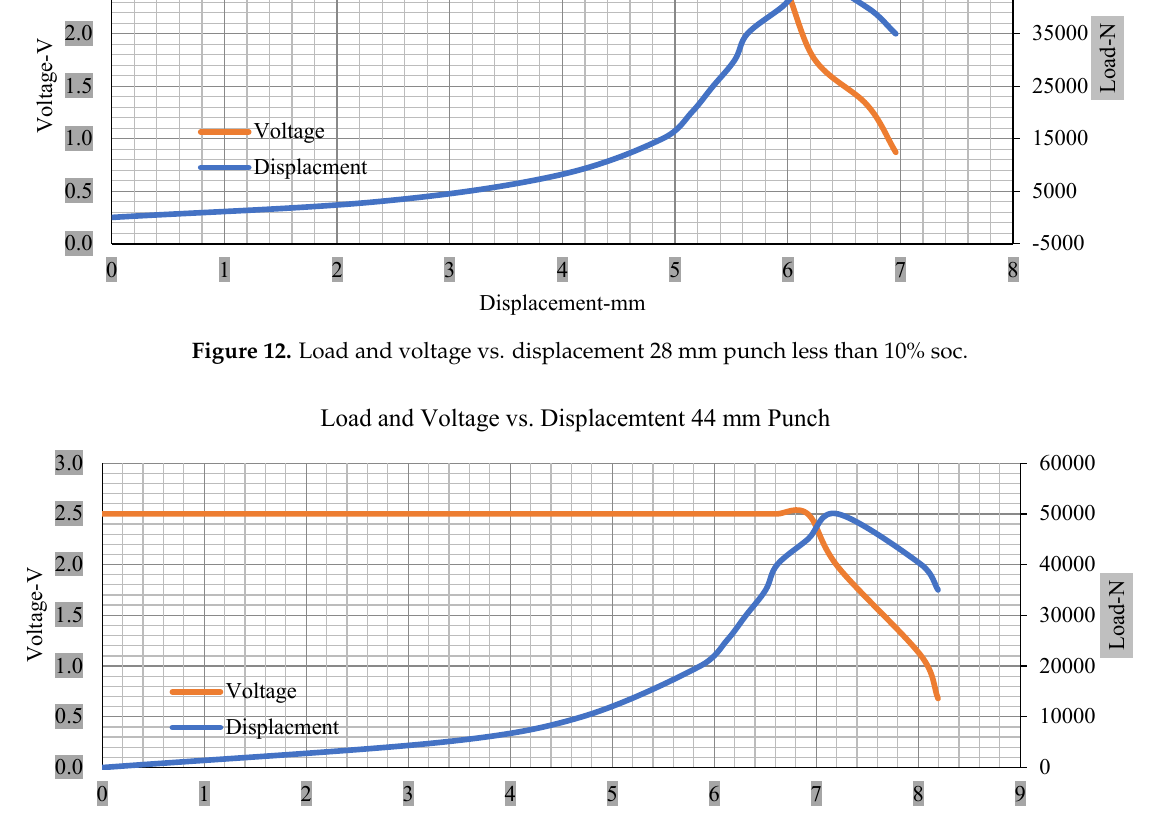
large punch, and flat cylindrical punch are 1.98, 1.01, 0.81, and 0.68. A drop in